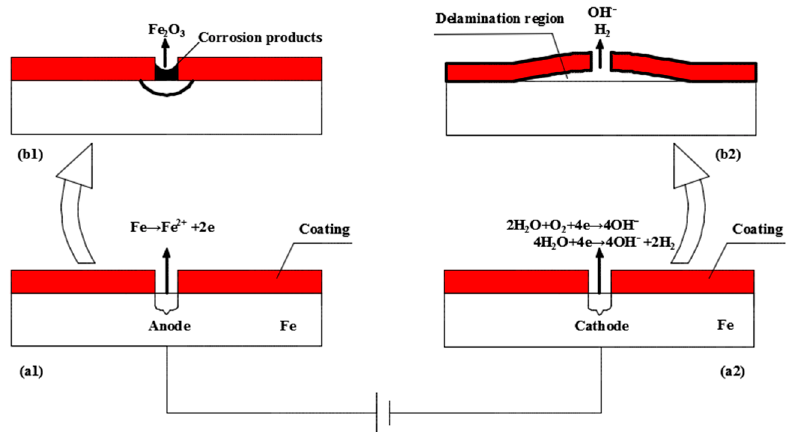
Figure 10. A schematic of the corrosion and organic cathodic disbondment mechanism of the pipeline under the DC stray current conditions.